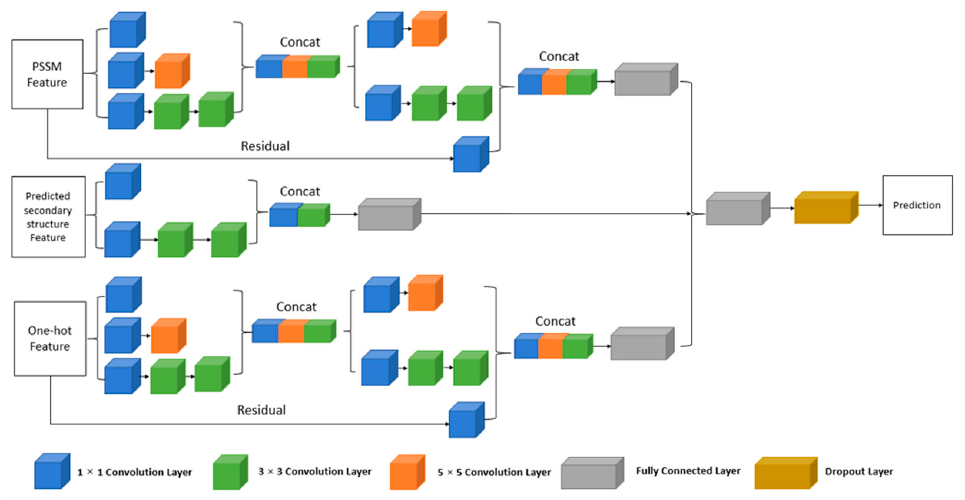
Figure 7. The structure of the proposed multi-IncepResNet-based predictor.